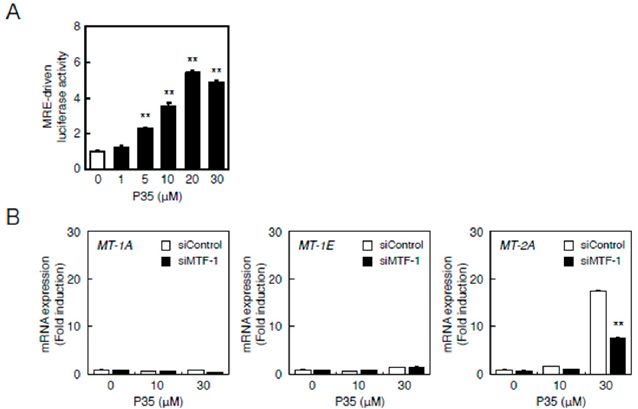
Figure 7. The MTF-1–MRE pathway mediates P35-induced transcription of endothelial MT-1A , MT-1E , and MT-2A . ( A ) Vascular endothelial cells transfected with an MRE reporter vector were treated with or without 1, 5, 10, 20, or 30 µM P35 for 12 h, and MRE-driven transcriptional activity was determined by performing the MRE-directed reporter assay. ** p < 0.01 indicates significantly different from the corresponding control; ( B ) P35-induced transcription of endothelial MT-1A , MT-1E , and MT-2A after MTF-1 knockdown. Vascular endothelial cells transfected with control or MTF-1 siRNA were treated with or without 10 or 30 µM P35 for 12 h. Data are expressed as the mean ± SE of three representative samples, with each sample obtained from three independent experiments. ** p < 0.01 indicates significantly different from the corresponding siControl.